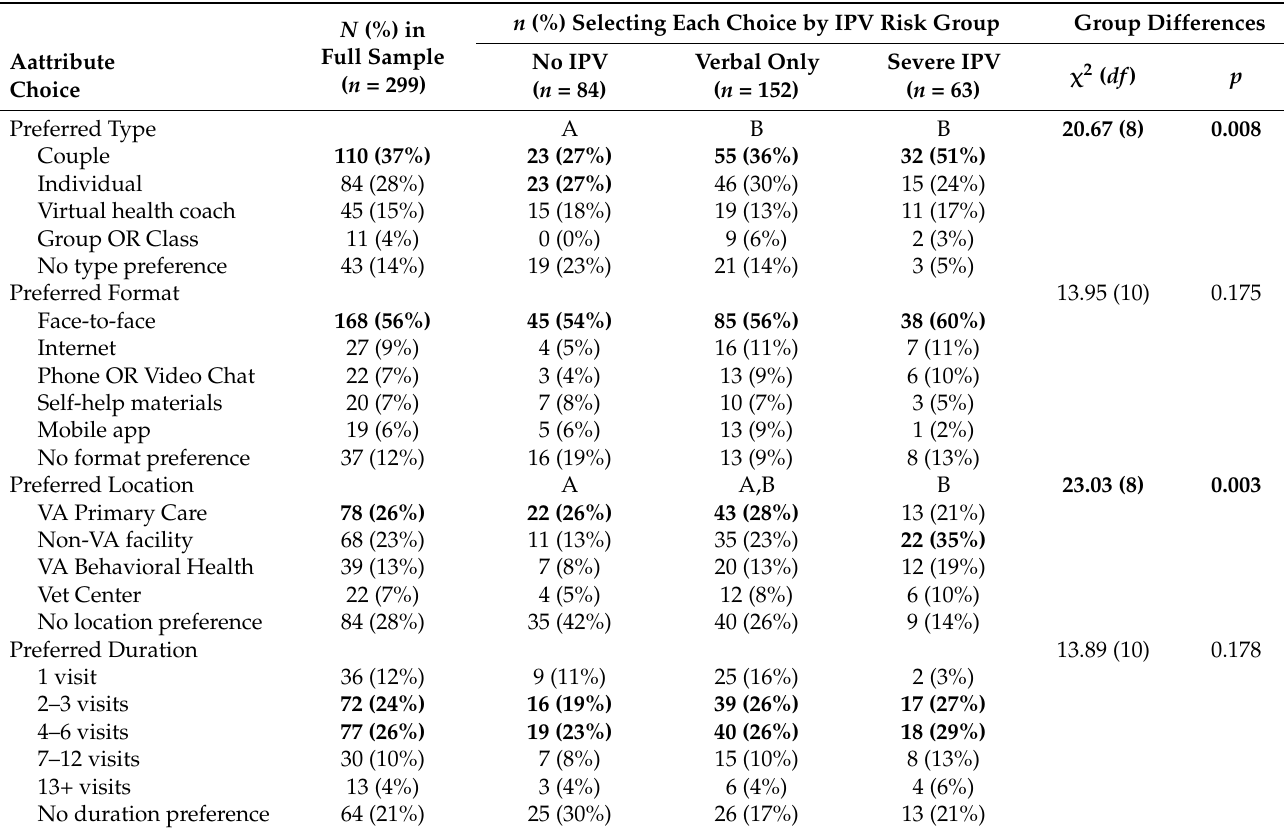
Table 3. Preferences for Treatment Attributes by Intimate Partner Violence (IPV) Risk